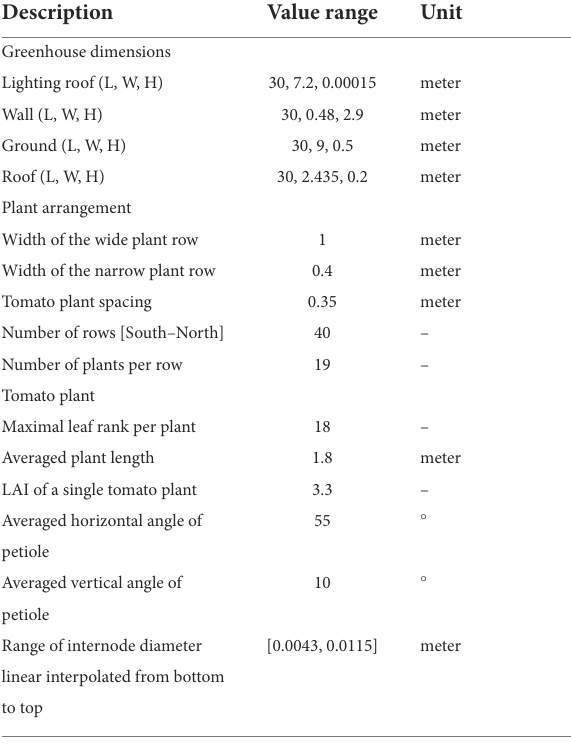
TABLE 1 General parameters of the virtual greenhouse and the virtual tomato plant population model.